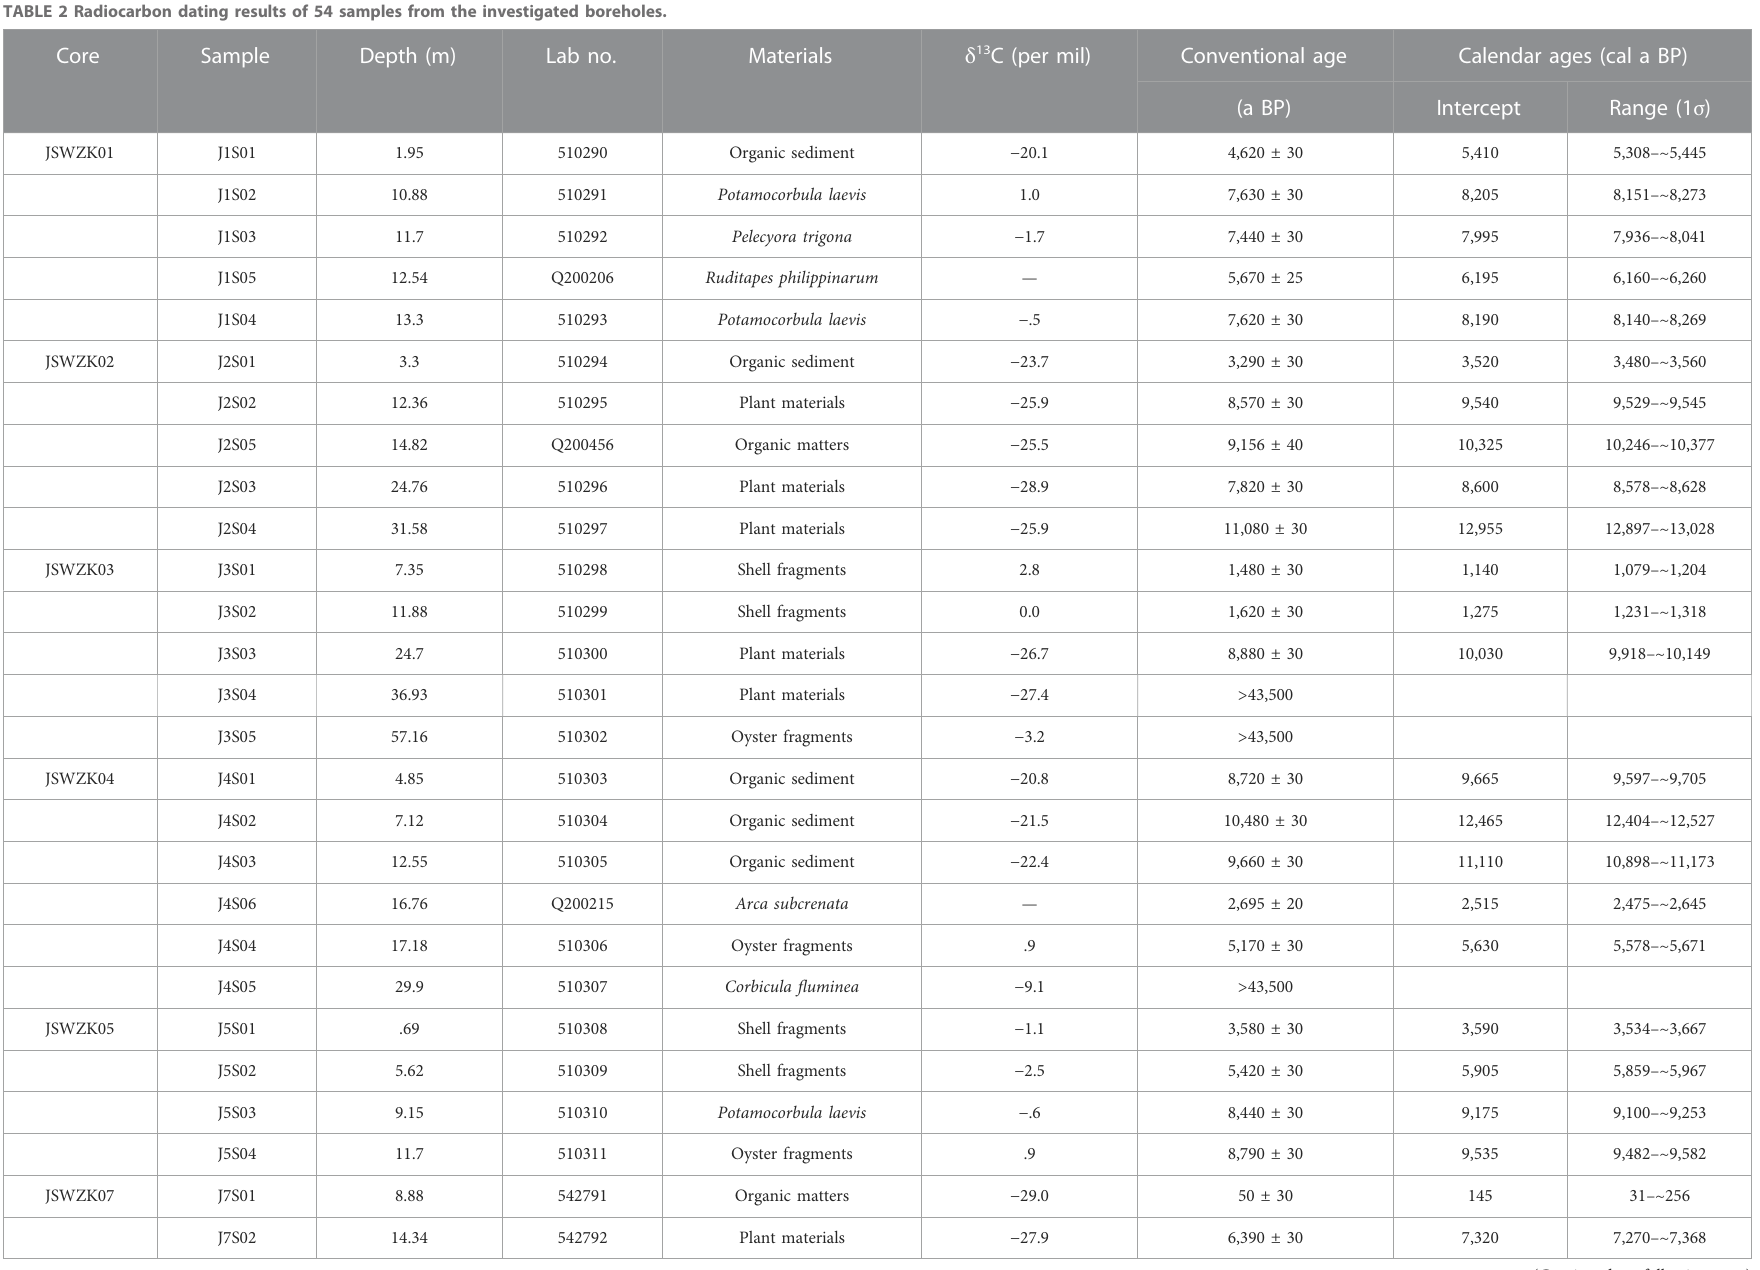
TABLE 2 Radiocarbon dating results of 54 samples from the investigated